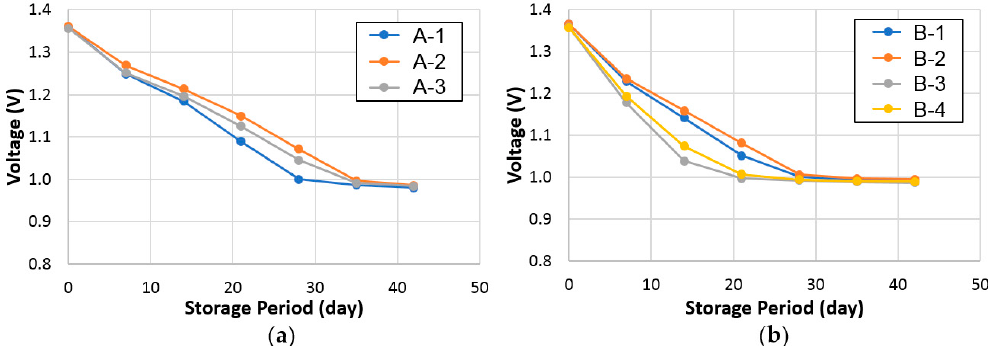
Figure 7. Open-circuit voltages of ( a ) cell A (set of three), and ( b ) cell B (set of four) stored at room temperature.